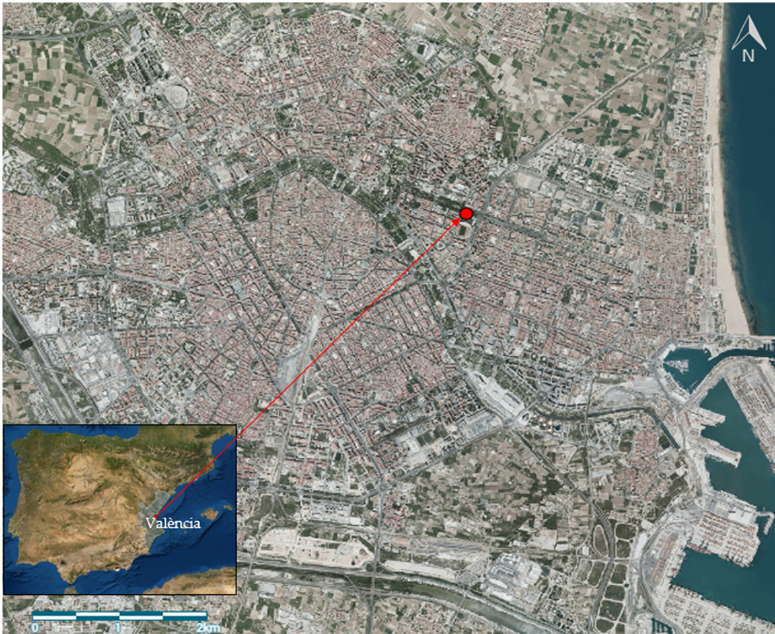
Figure 1. Location of the rain gauge station in Valencia. Images taken from Institut Cartogràfic Valencià, Generalitat Valenciana (https://visor.gva.es/visor/, accessed on 3 July 2021) and Google Earth.